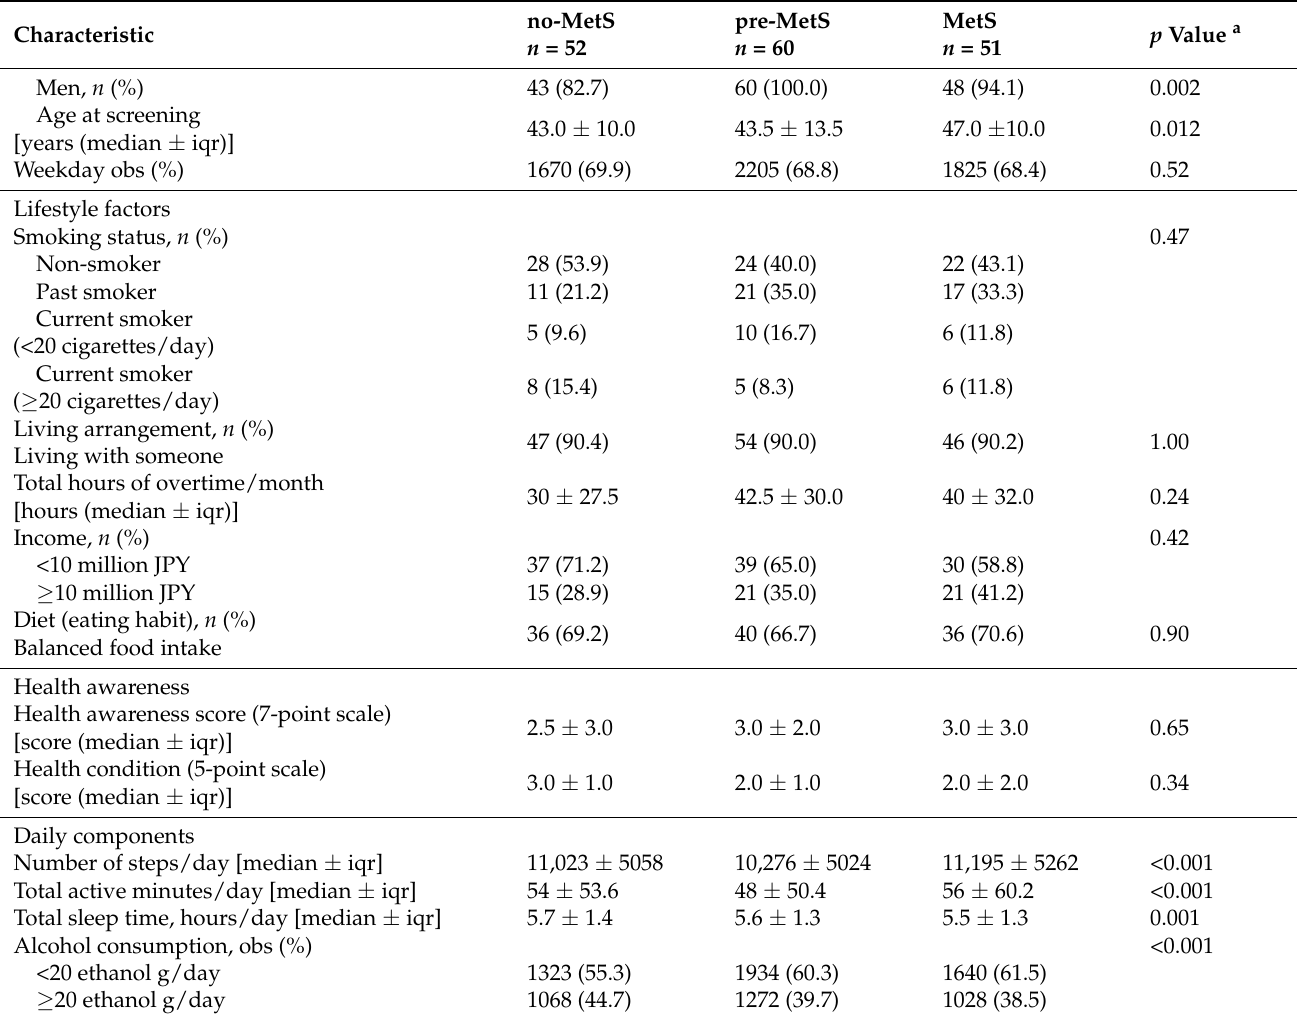
Table 1. Baseline characteristics according to metabolic syndrome status ( n =